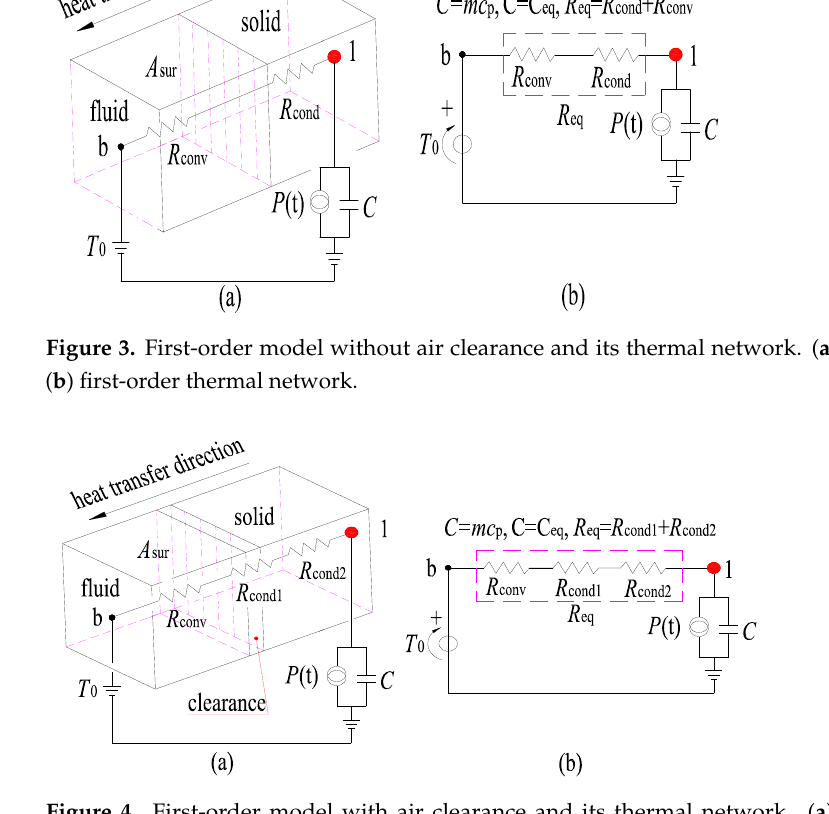
p e Figure 5. Transient temperature curve of stator yoke iron for different α . ( a ) Direct cooling condition, ( b ) indirect cooling. 3.2. Multi-Order LPTN Theory The transient temperature rise can be solved by the following differential equation. N o d e t e m